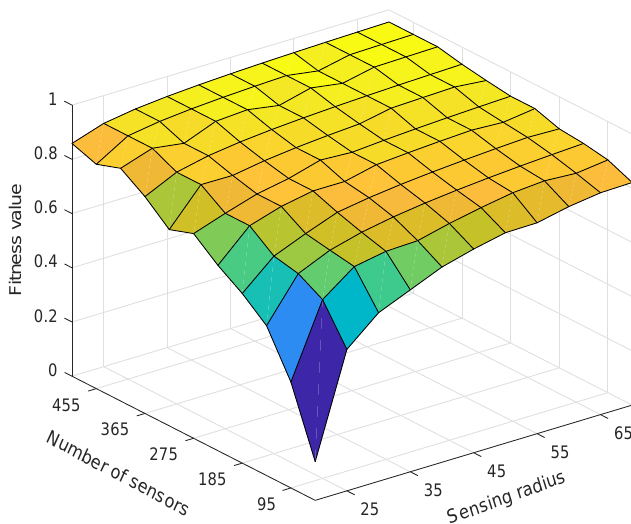
Figure 6. The change trend of the fitness function when the number of nodes changes and the node sensing radius r s changes.